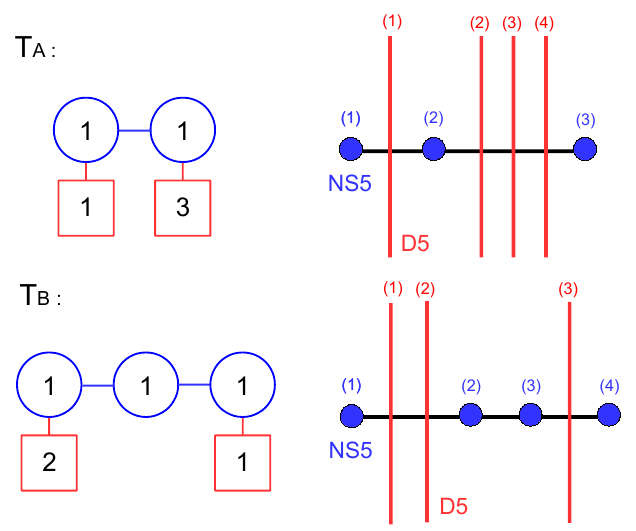
Figure 28 . Quiver diagrams and brane con(cid:12)gurations of the mirror dual theories T A and T B